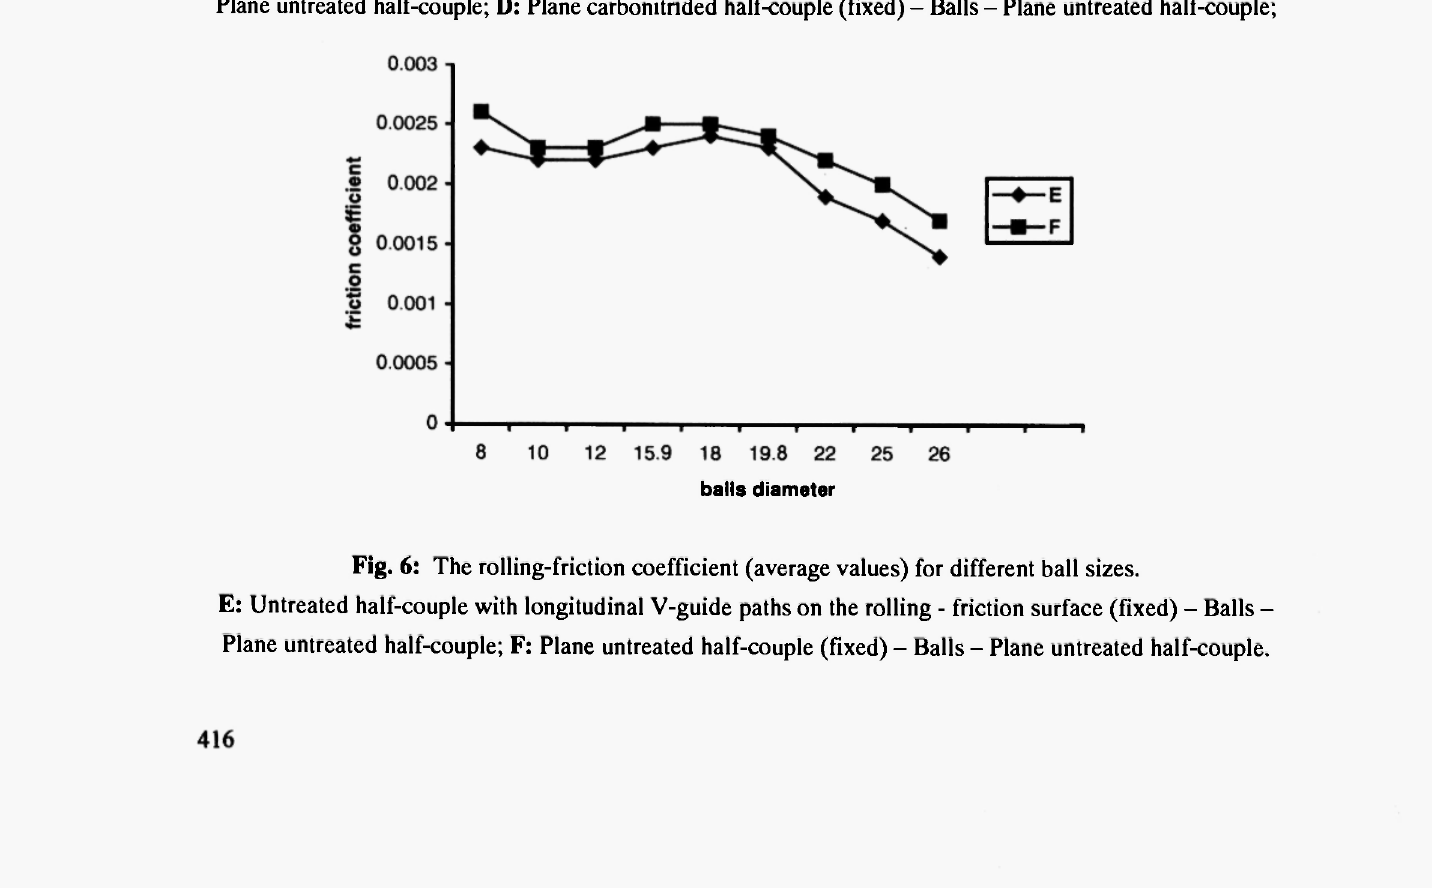
Fig. 5: The rolling-friction coefficient (average values) for different ball sizes. C: Carbonitrided half-couple with longitudinal V-guide paths on the rolling (fixed) - friction surface - Balls - Plane untreated half-couple; D: Plane carbonitrided half-couple (fixed) - Balls - Plane untreated half-couple;